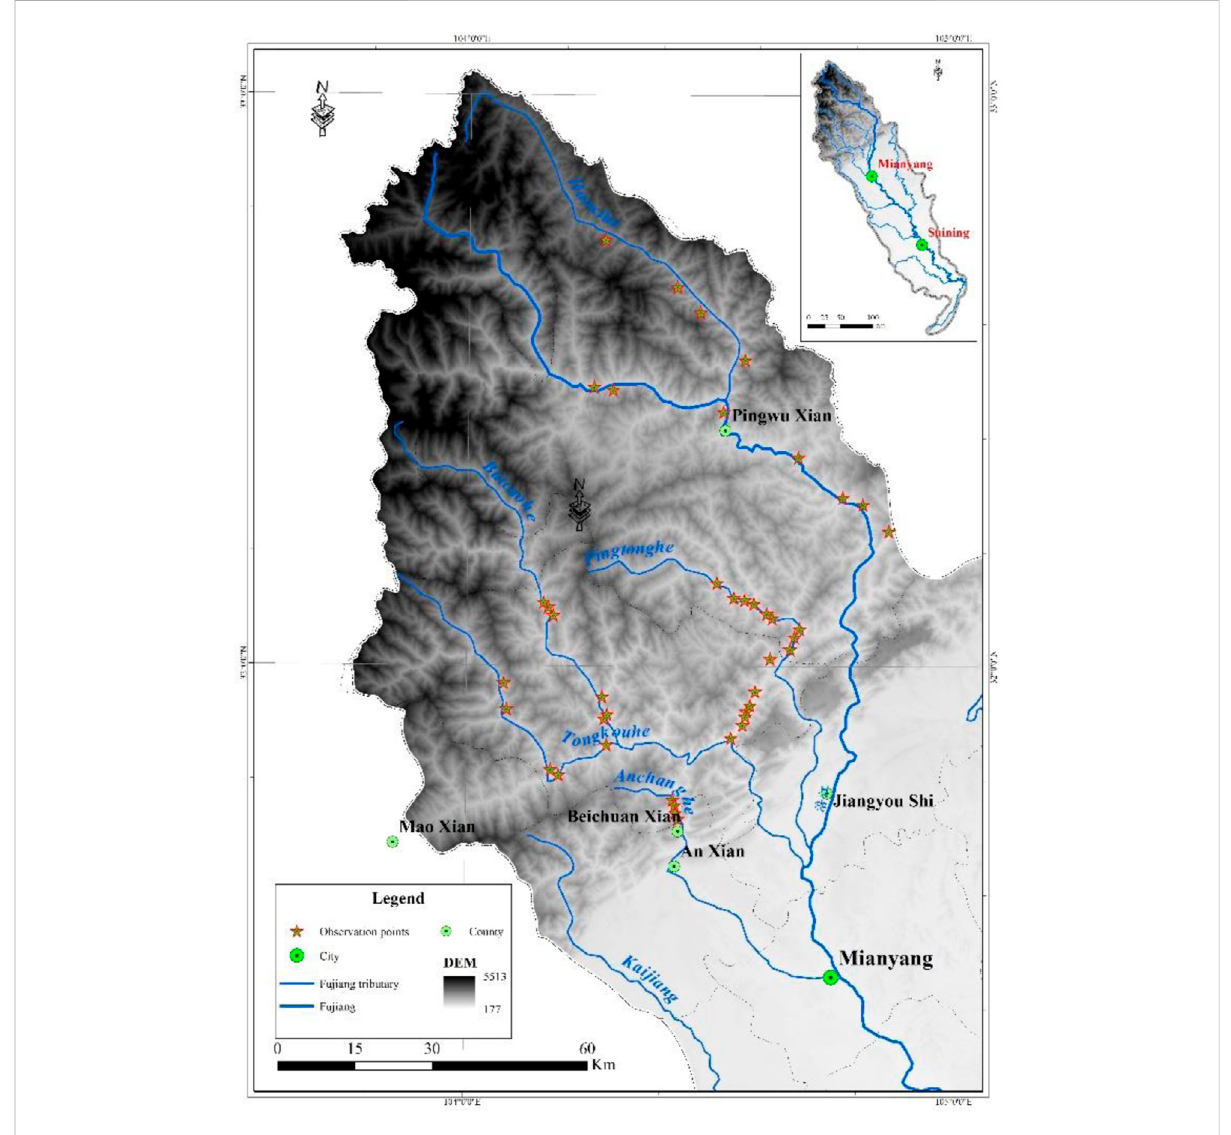
FIGURE 1 The fi eld survey location of the Fujiang River